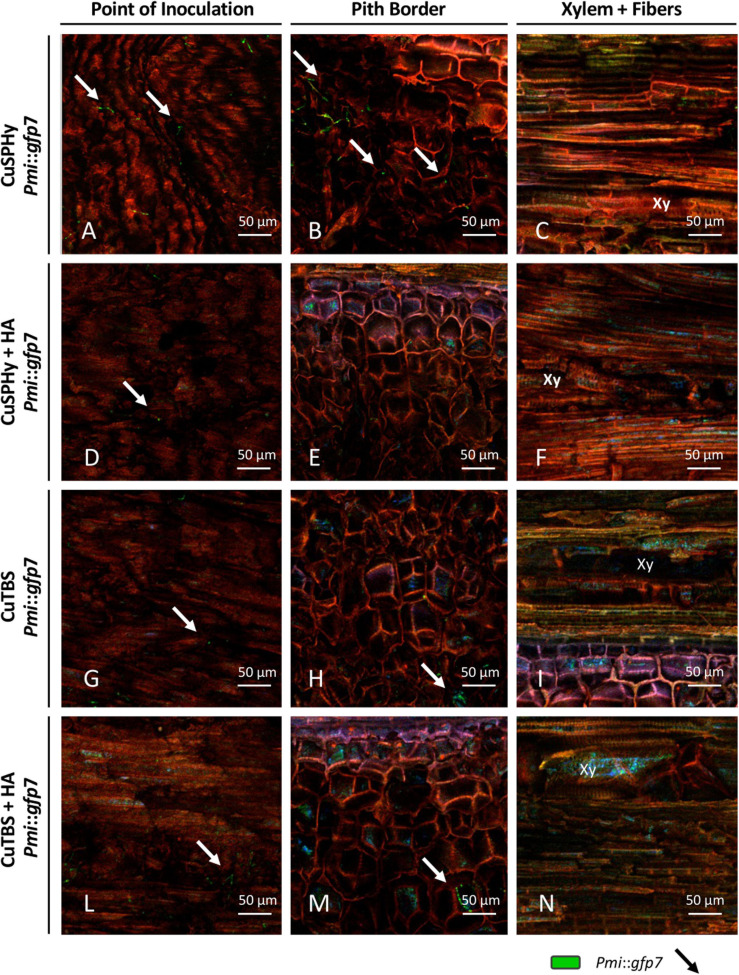
CLSM observations (four repetitions) of grafted vines samples cv. Chardonnay on Kober 5BB rootstock (six technical replicates), harvested 15 weeks post Pmi inoculation. Images are referred to the longitudinal section of the inoculation site (3 cm above and 3 cm below) at the rootstock level and presented according to the cupric treatments, CuSPHy (A–C), CuSPHy + HA (D–F), CuTBS (G–I), CuTBS + HA (L–N), and the plant tissue, point of inoculation (A,D,G,L), pith border (B,E,H,M), and xylem with fibers (C,F,I,N). Xy: xylem.